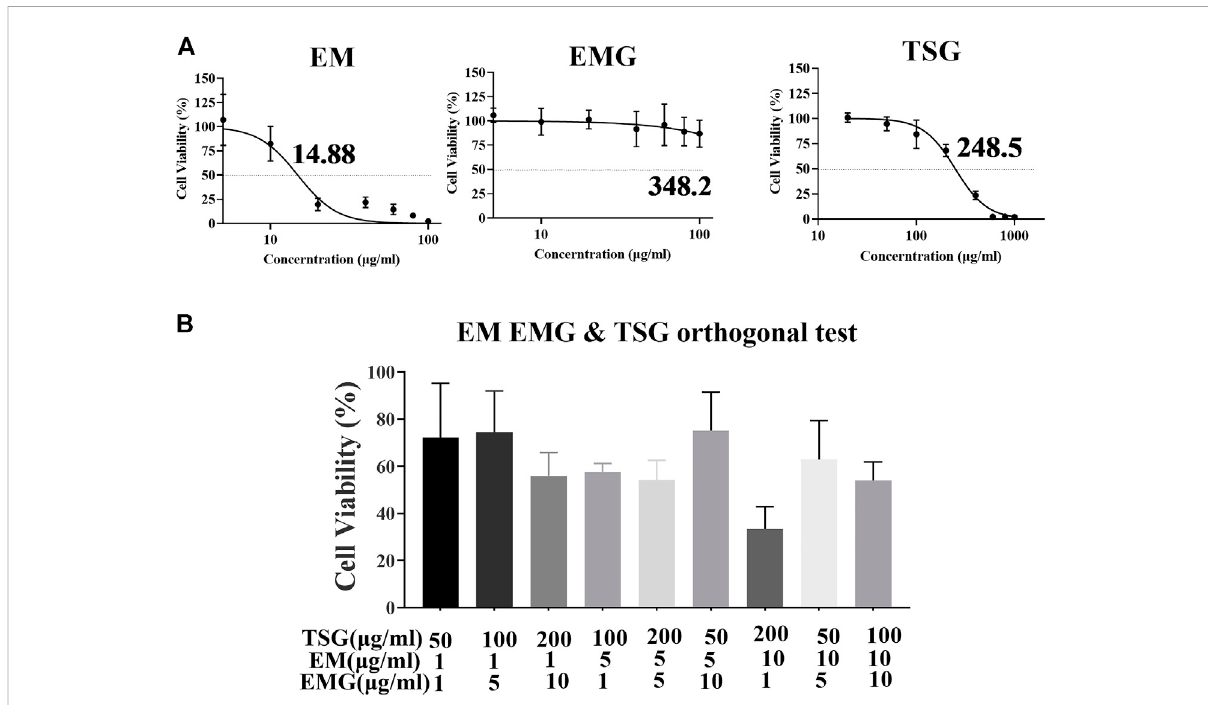
FIGURE 6 Orthogonal experiment results of TSG, EM and EMG combination in L02 cell line. Data were expressed as mean ± SD (n = 3 independent replicates). (A) Concentration-cellviabilitycurvesforemodinat1 – 100 μ g/ml,EMGat1 – 100 μ g/ml,andTSGat20 – 1000 μ g/ml. (B) Cellviabilityafter the treatment of nine orthogonal combinations of TSG, EMG and emodin at high, medium and low concentration levels for 48 h.